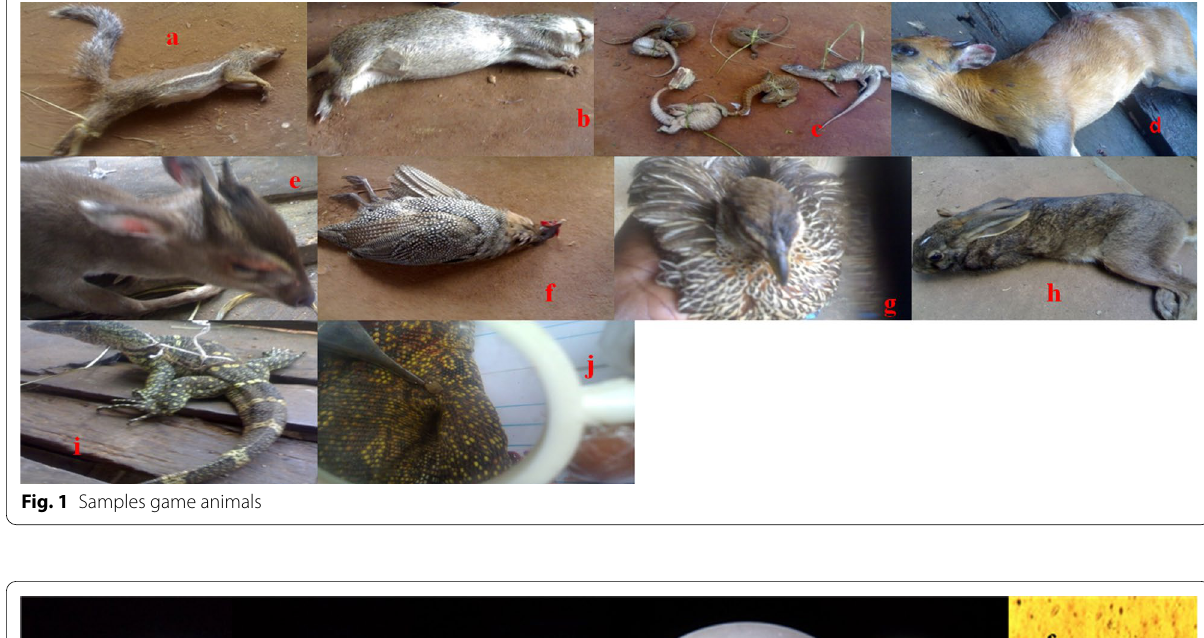
Fig. 2 Ectoparasites found from game animals. j – k